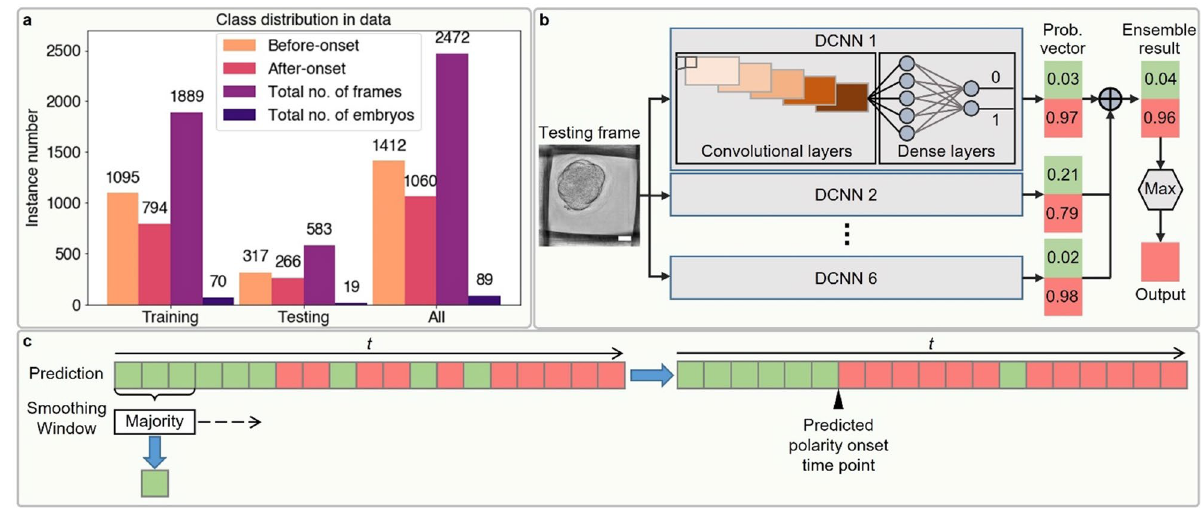
Figure 2. An ensemble deep learning approach to predict embryo polarization from DIC images. ( a ) Class distribution in the training/testing/whole dataset. ( b ) Ensemble learning on six DCNN models. The predicted probability vectors for two classes on a single testing frame by six DCNN models were averaged element- wisely and the class corresponding to the larger probability was used as the final predicted label. ( c ) Temporal smoothing on the predicted labels for each testing embryo’s DIC frame sequence. The majority voting based smoothing window slid over the chronologically ordered binary labels. The window length is 3 and we kept the label at both ends untouched. Finally, the time index of first after-onset prediction was taken as the final prediction of polarity onset time point. Scale bar = 20